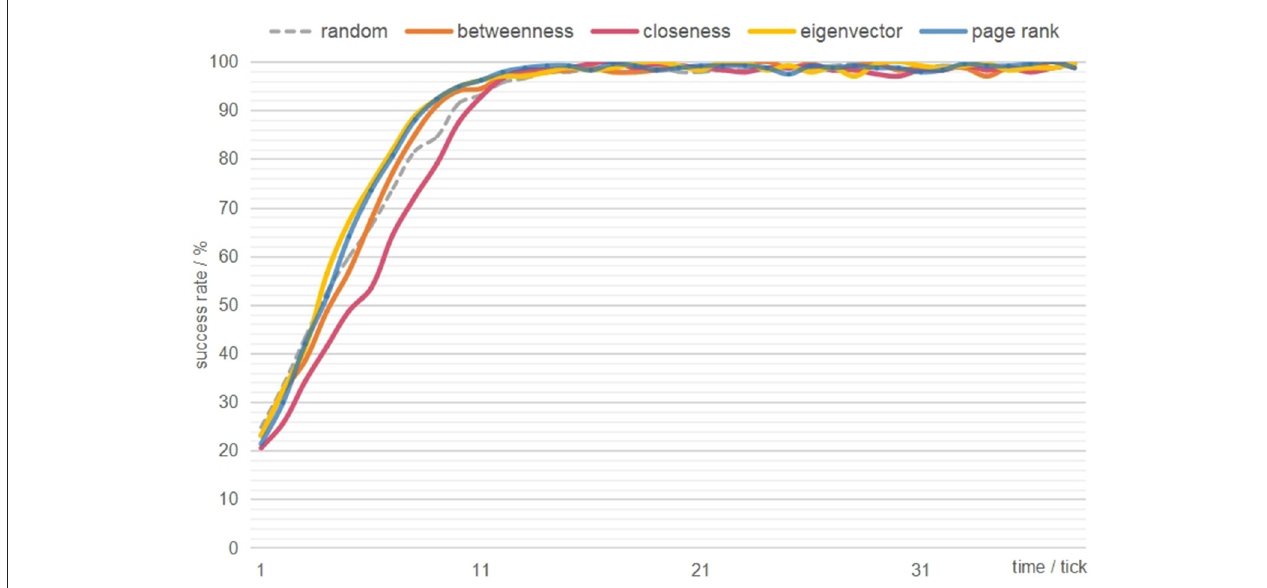
FIGURE 2 | Intervention outcomes of the random and four centrality-based conditions.